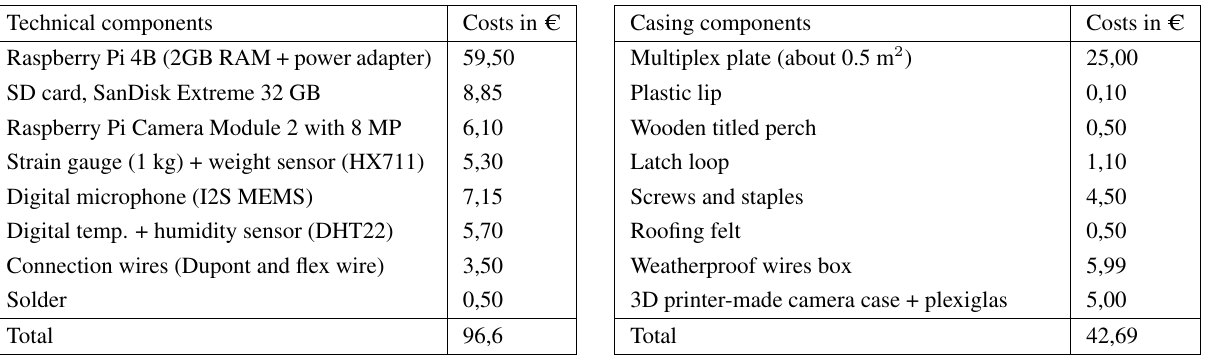
Table 1. List of all technical components needed to operate the feeder, including the costs.